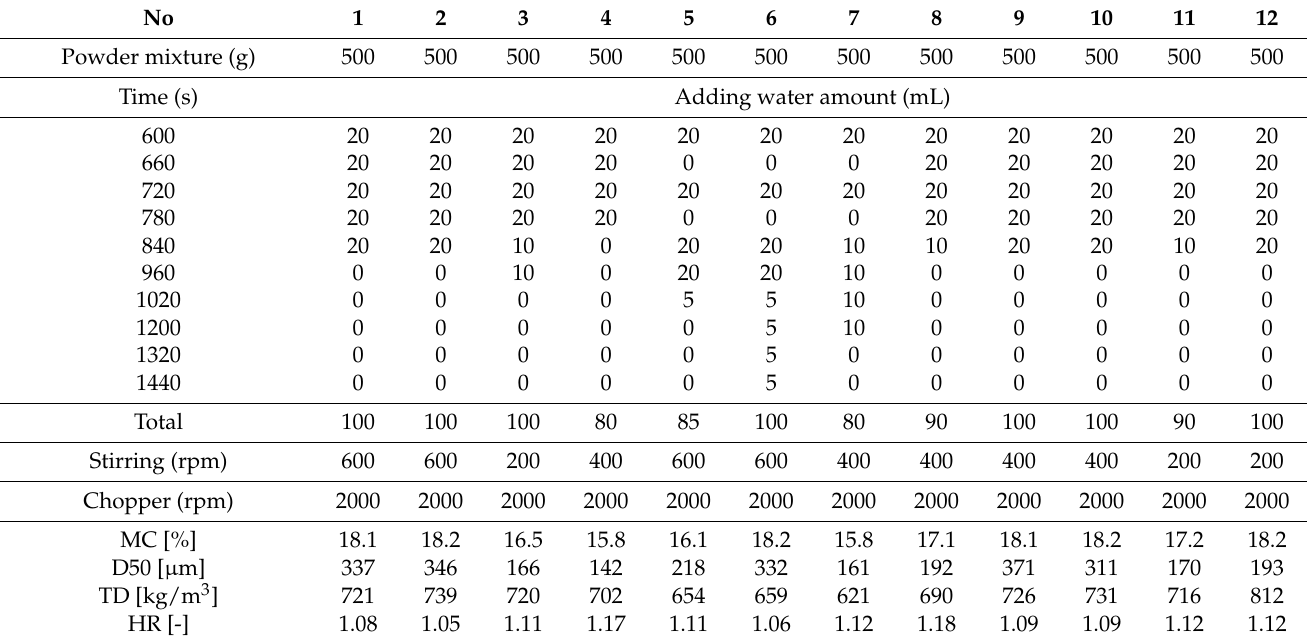
Table 1. Preparation and various pharmaceutical properties of HSWG granules for the calibration model.